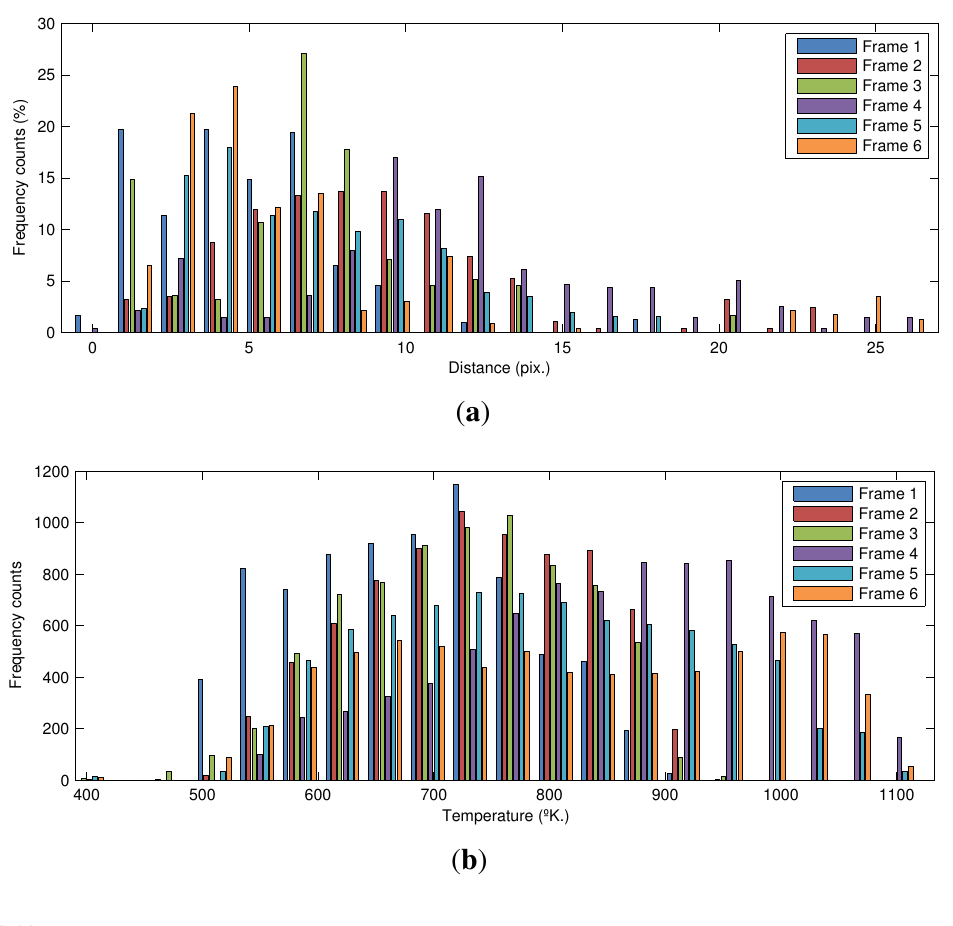
Figure 15. Histograms for the flame front zone in all key frames. ( a ) Histogram of the distance from the maximum temperature values in the flame front to the bottom limit of the ROI; ( b ) histogram of the temperature values in the flame